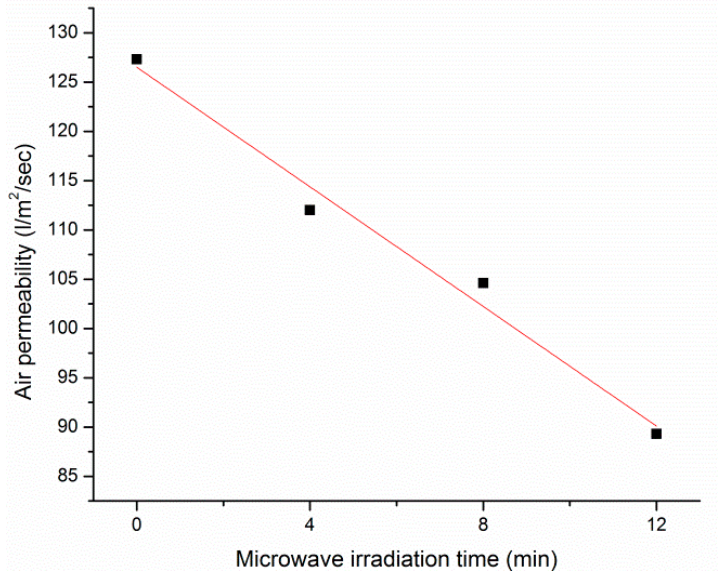
Figure 13. Air permeability property of the ZnO-nanorod-coated fabric at different microwave irradiation times.